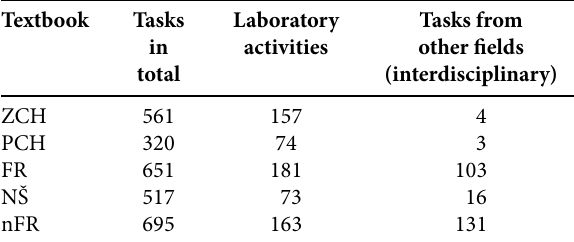
Table 2: Number of tasks in lower-secondary chemistry textbooks